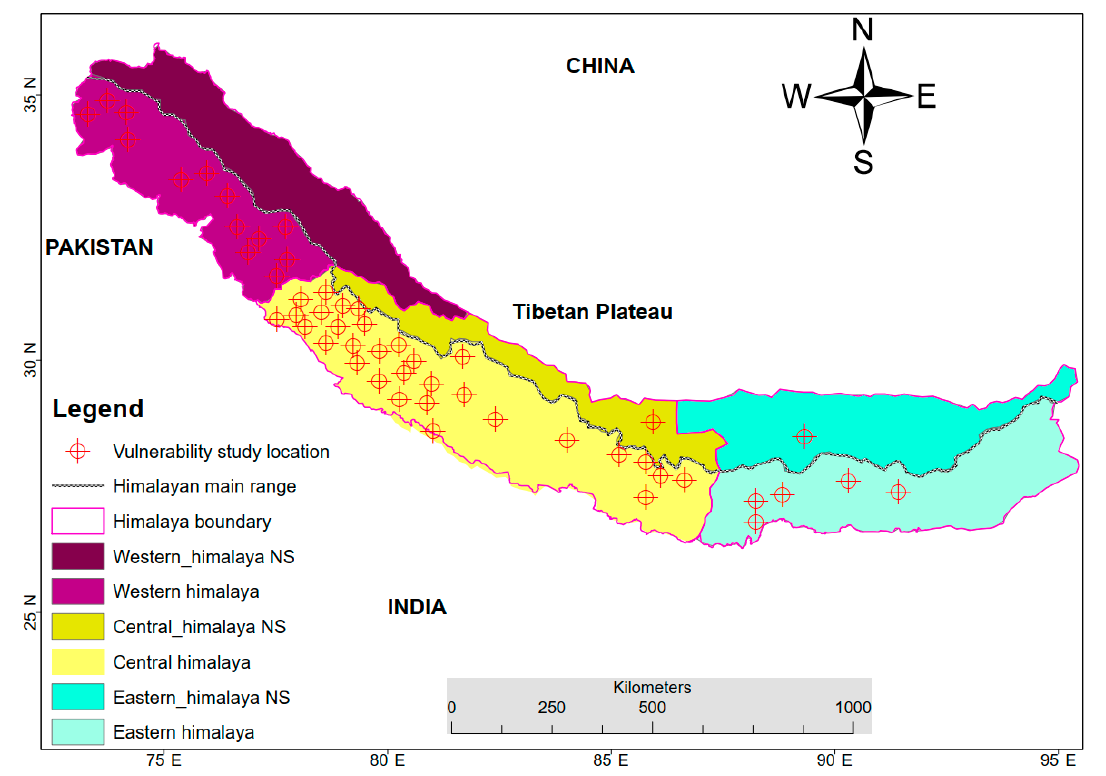
Figure 3. The location of the vulnerability studies. Note: The main Himalayan range divides the northern and southern parts of the Himalayas. The darker colors represent the northern slopes (NS) of the Himalayas.